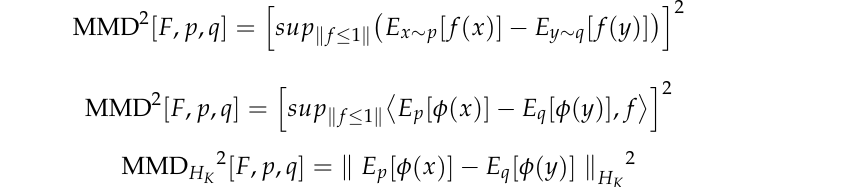
Figure 10. Purpose of Center Loss + MMD.